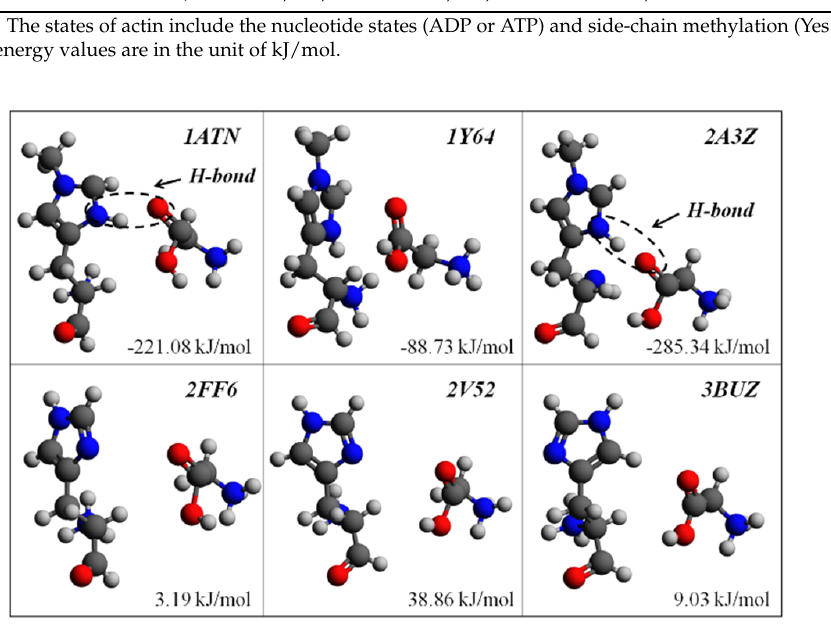
Figure 3. Conformations of the six His73/Gly158 interactions. The structures of the first three (upper row) are of methyl groups on the side chain. H-bonds (N-H ··· O) can be found on 1ATN and 2A3Z but not on 1Y64. The binding energies on the unmethylated structures (lower row) are all above zero, which would result in the structural instability of the nucleotide sites on actin. Color key: O, red; C, gray; N, blue; H, silver. The ab initio calculation results suggest that actin structures with side chain methyl groups all present higher structural stability. Nyman, et al. proposed that the side chain methylation of His73 would affect the interaction between His73 and its neighboring residues [11]. A typical mechanism for H-bond formation induced by His73 methylation is provided in Figure 4. When His73 is methylated, the side chain is fully substituted and carries one positive charge, which is shared between the two nitrogen atoms ( δ 1 and ε 2, refer to Figure 3). This positive charge will contribute to enhancing the H-bond interaction between His73 and